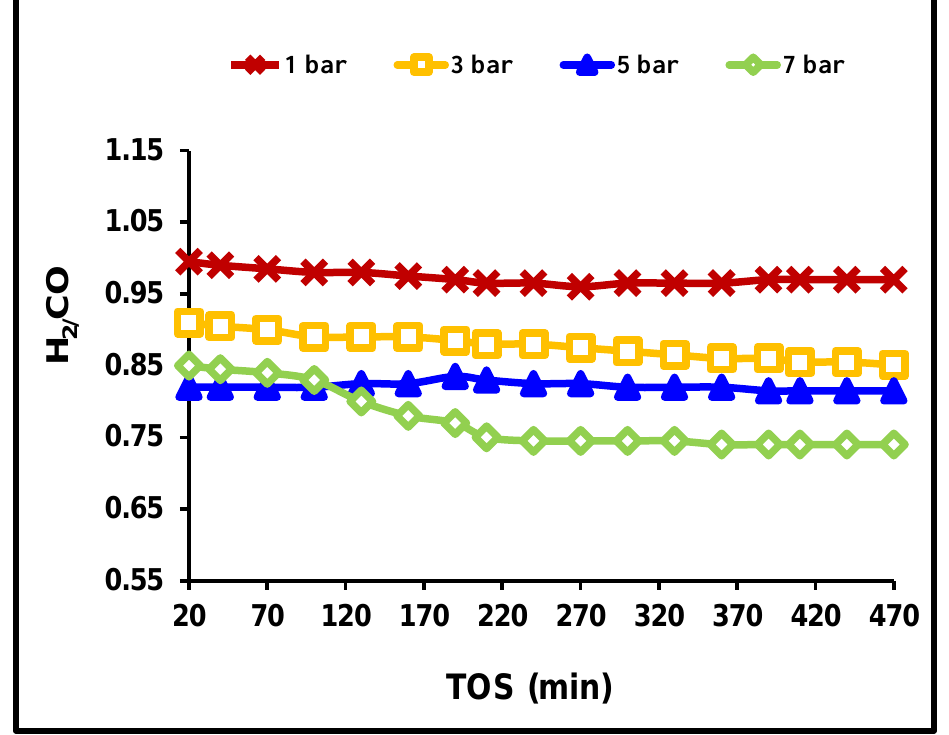
Figure 4. TOS against hydrogen and carbon monoxide ratios, for catalyst: calcination at 725 ° C, activation at 750 ° C, reaction at 700 ° C, 0.05g catalyst, CH 4 = 30 mL/min, CO 2 = 30 mL/min, N 2 = 10mL/min, GHSV = 84000 (mL/g/h).